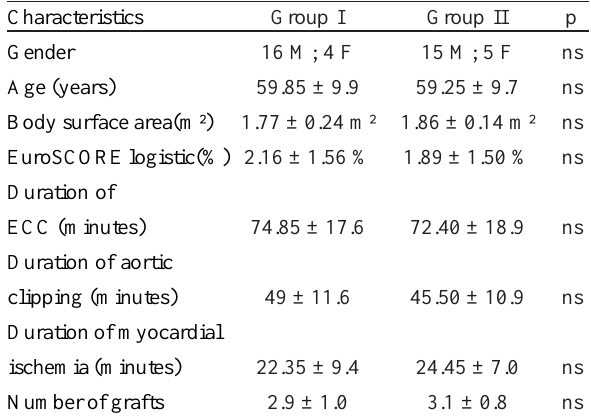
Table 1. Clinical characteristics of the 40 patients who underwent cardiac artery bypass graft (CABG)